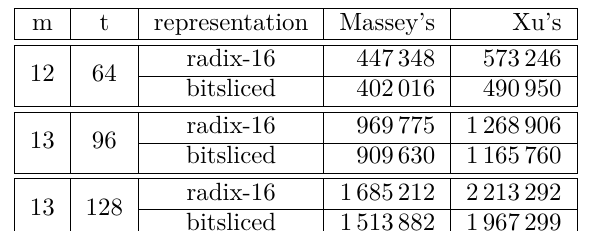
Table 13: Cycle counts of BM with different implementation choices when the frequency is set to 24 MHz. Note that the parameter sets mceliece348864* use ( m, t ) = (12 , 64); mceliece460896* use ( m, t ) = (13 , 96); mceliece6688128* and mceliece8192128* use ( m, t ) = (13 ,